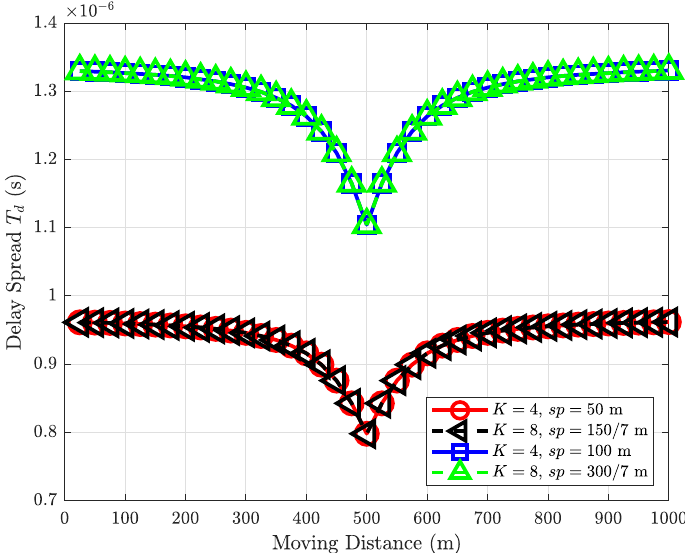
Figure 7. Delay spread for different spacings of RIS. K =